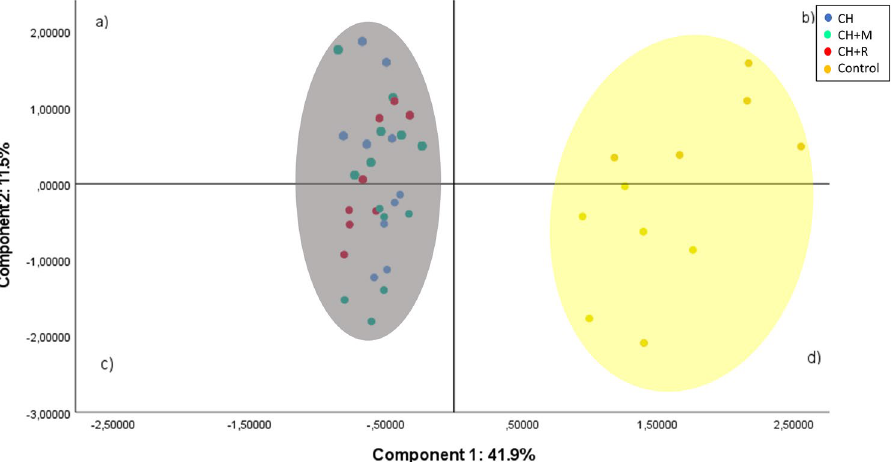
Figure 2. Principal component analysis (PCA) score plot using total lipids, cholesterol, fatty acid composition, diterpene profile and pigments in the liver of piglets. Dietary treatments: Control—control diet; CH—5% Chlorella vulgaris diet; CH+R—5% Chlorella vulgaris diet supplemented with 0.005% Rovabio Excel AP; CH+M—5% Chlorella vulgaris diet supplemented with 0.01% enzymatic